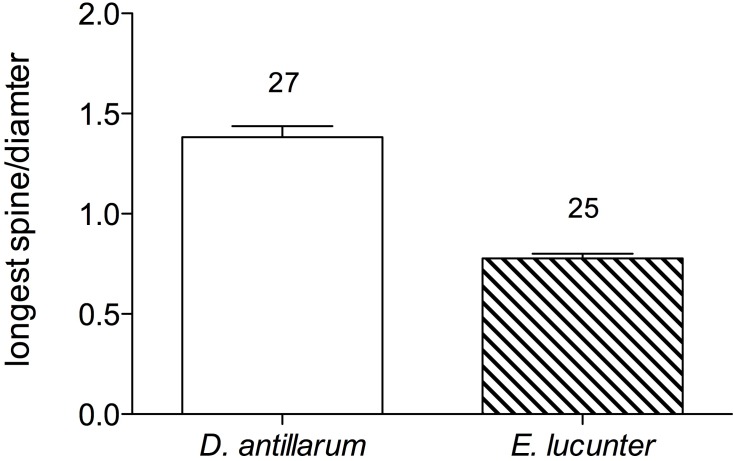
Mean ratio of longest spine per test diameter (±SEM) of Diadema and Echinometra (t = 10.74, df = 51; p < 0.0001).Sample sizes are indicated above the bars.